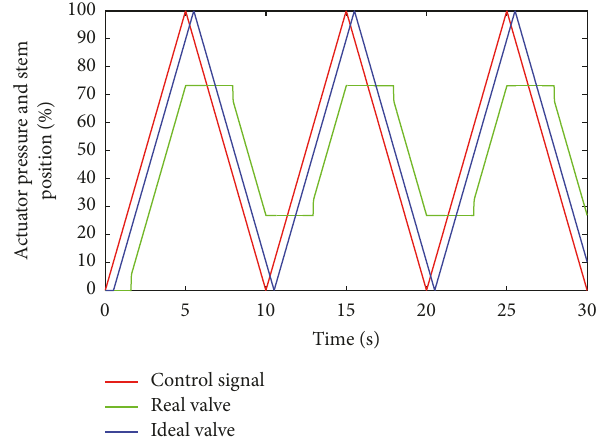
Figure 3: Valve responses to an input of a triangular signal.